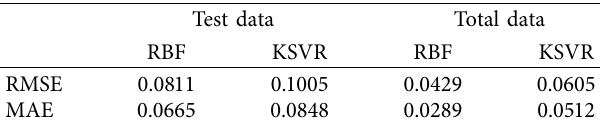
Table 12: Comparison of RBF and KSVR models for estimating